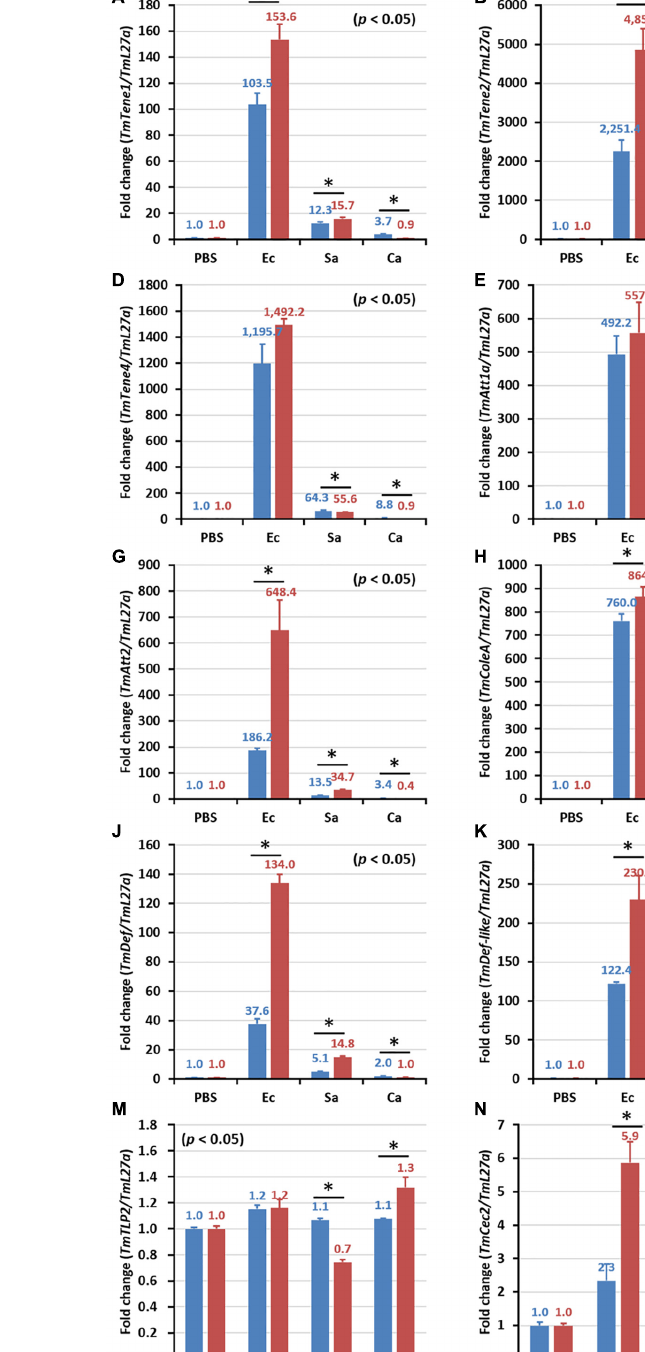
Frontiers in Physiology |